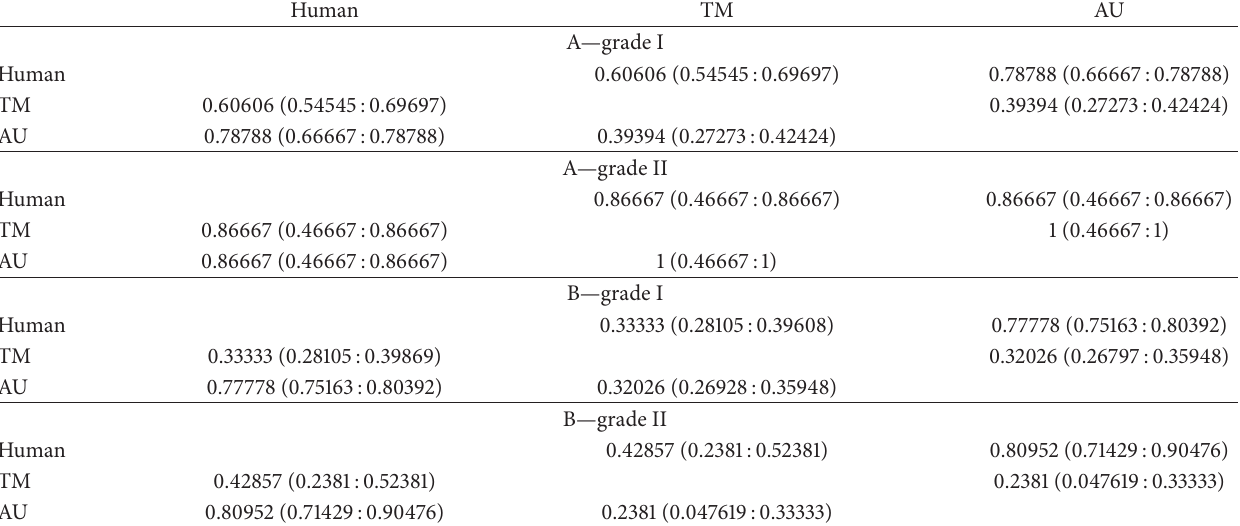
Figure6:ThemeanandstandarddeviationofthescoringKi-67indexforall50examinedglassslidesandtheirWSIderivedfrommeningioma patients. Data are grouped according to the types of measurements, grade of malignance (grade I, grade II, and grade III), and type of sample preparation method (sets A and B). In each of the three bars the first, blue bar shows the result for the manual microscopic expert score and the second, red bar shows the result for the mean of the pathologists’ quantifications using WSI, while the third, green bar presents results for the proposed automated method. Table4:Theresultsofpooled(forallexperts)agreementanalysisofcategorizeddatausingKendall’stau-banalysisforinterobservervariability on the WSI from sets A and B separately. The data are grouped in categories, grade I and grade II, while grade III was excluded from the analysis because of the small number of WSIs (3) in this category. TM means classical expert microscopic review, Human means the mean of the pathologists, and AU means the proposed automatic